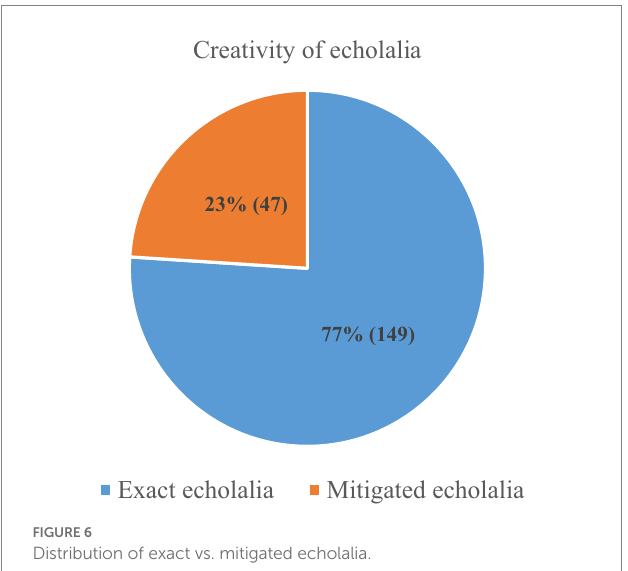
FIGURE 6 Distribution of exact vs. mitigated echolalia.